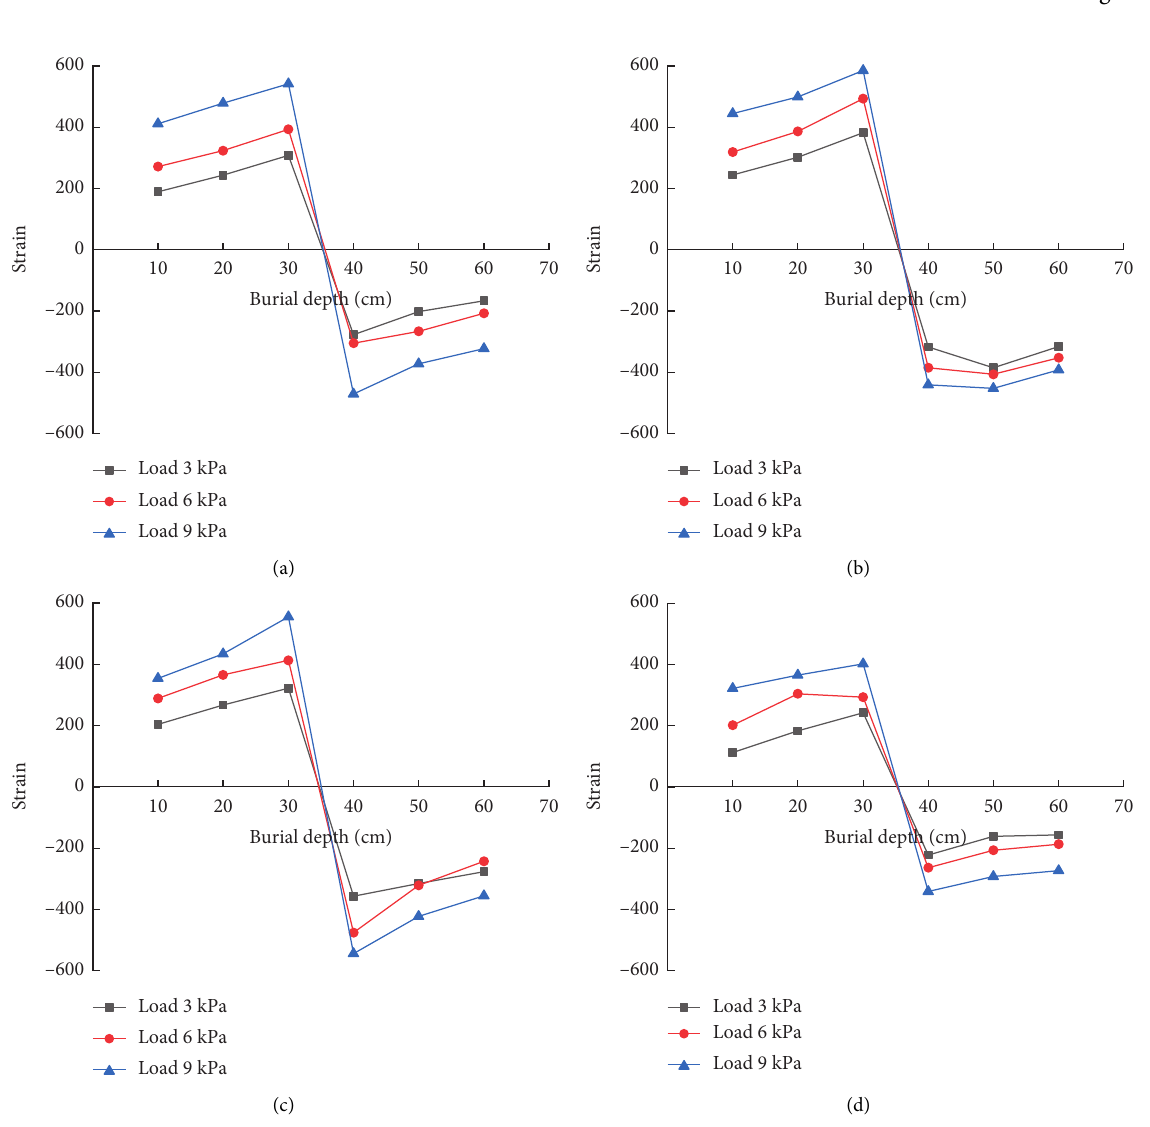
Figure 7: Distribution curves of strain on pile bodies. (a) Pile #2. (b) Pile #4. (c) Pile #5. (d) Pile